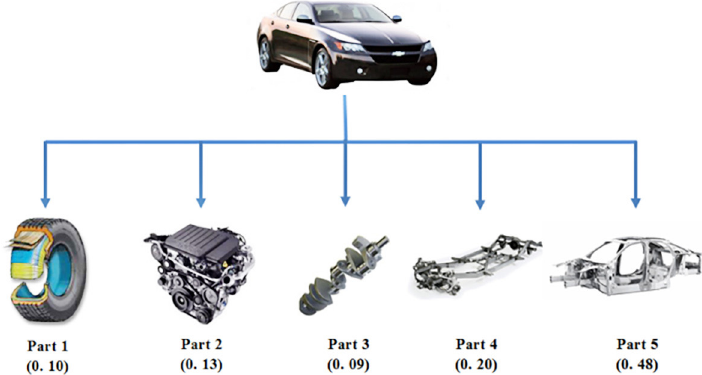
Fig. 2. Bill of material of the final